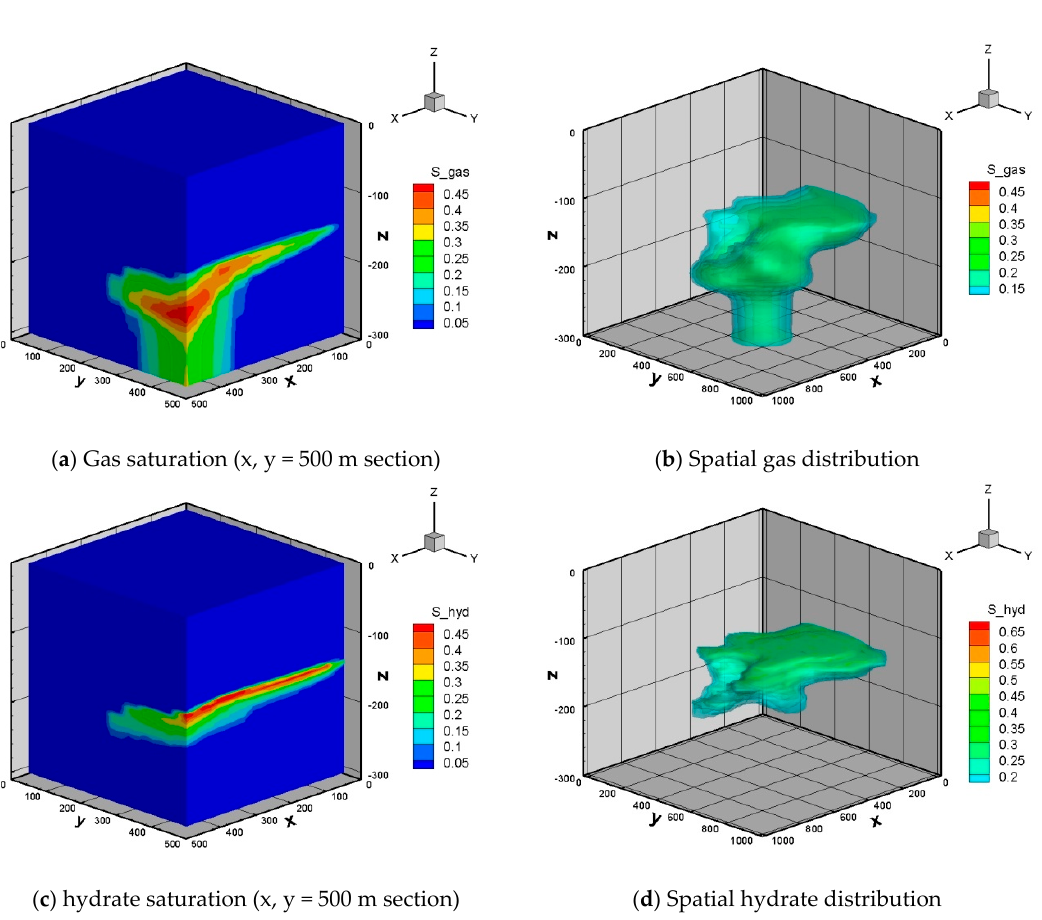
Figure 6. Gas and hydrate distribution at a simulated time of 1000 years (Case 2).